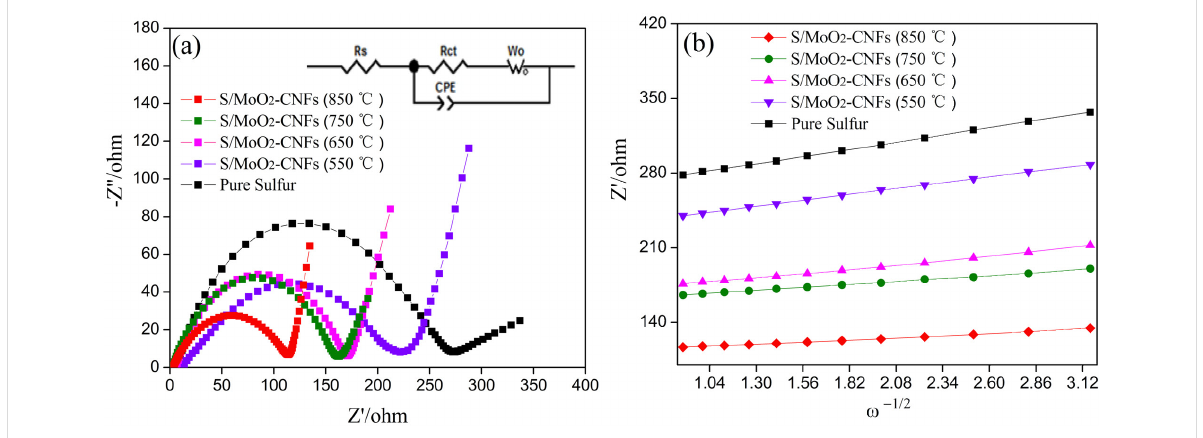
Figure 6: (a) Electrochemical impedance spectroscopy of MoO 2 –CNFs calcined at different temperatures with sulfur cathodes and a pure sulfur cathode. (b) The dependence of Z ’ ( Z re ) on the reciprocal square root of the frequency ω − 1/2 in the low-frequency region of five electrodes.